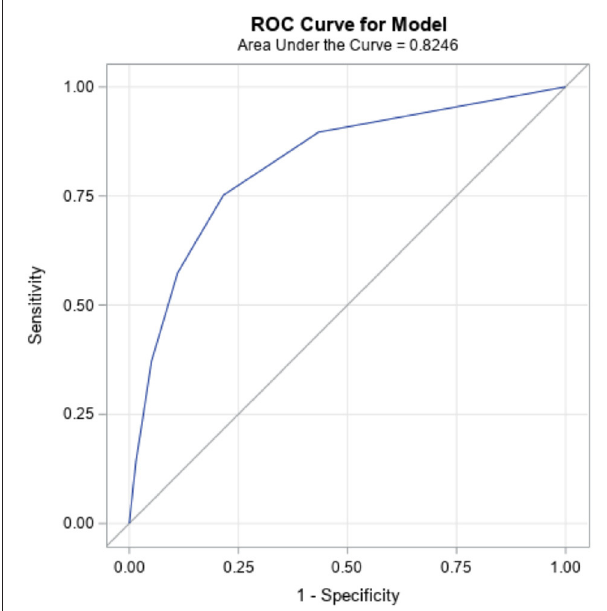
FIGURE 1 | Receiver Operator Characteristics (ROC) Curve: Five-item scale.